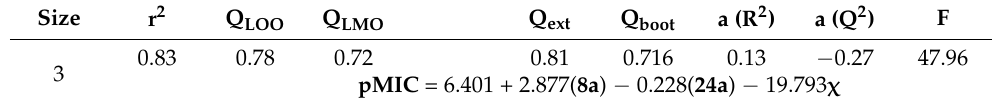
Table 2. Different statistical values of the predictive capacity of QSAR model